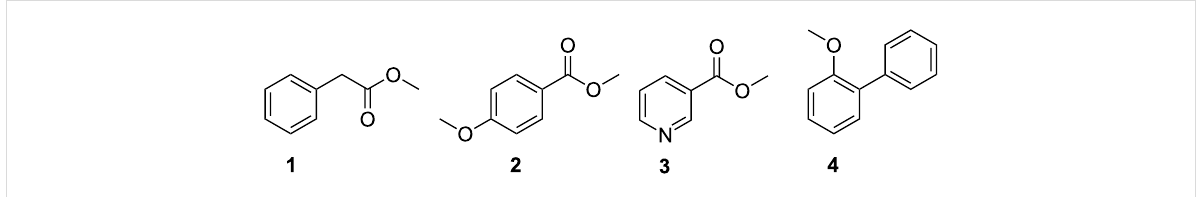
Figure 1: Volatile compounds released by Mycobacterium tuberculosis and M. bovis identified in previous studies [9].